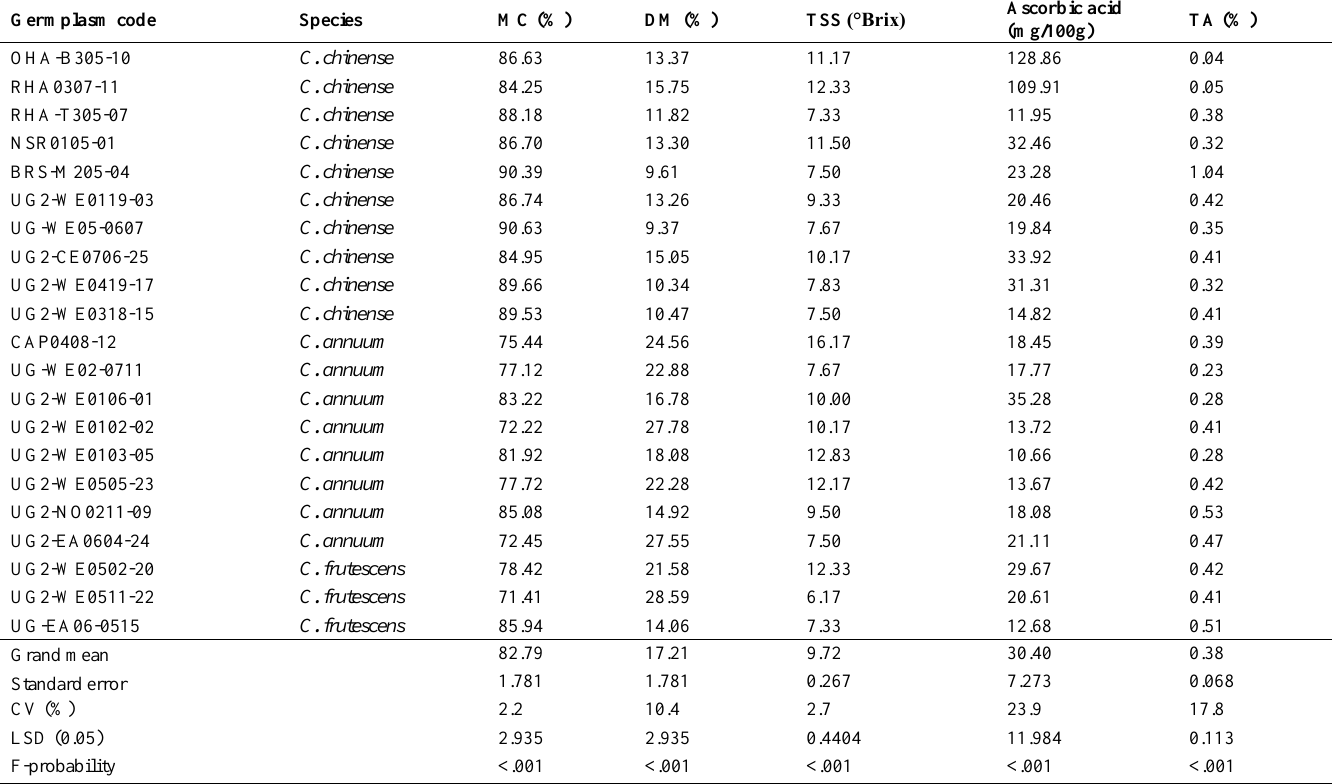
Table 2 . Means of quantitative fruit attributes in the studied selected Capsicum genotypes